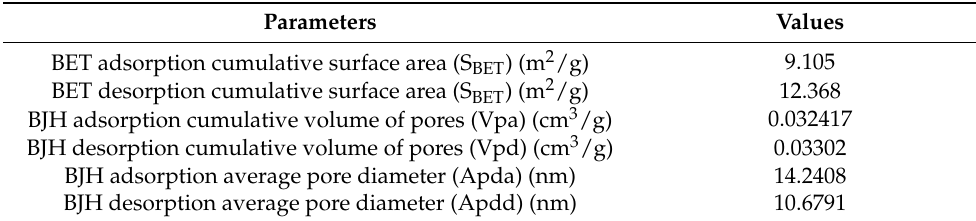
Table 2. Adsorption and desorption surface parameters of